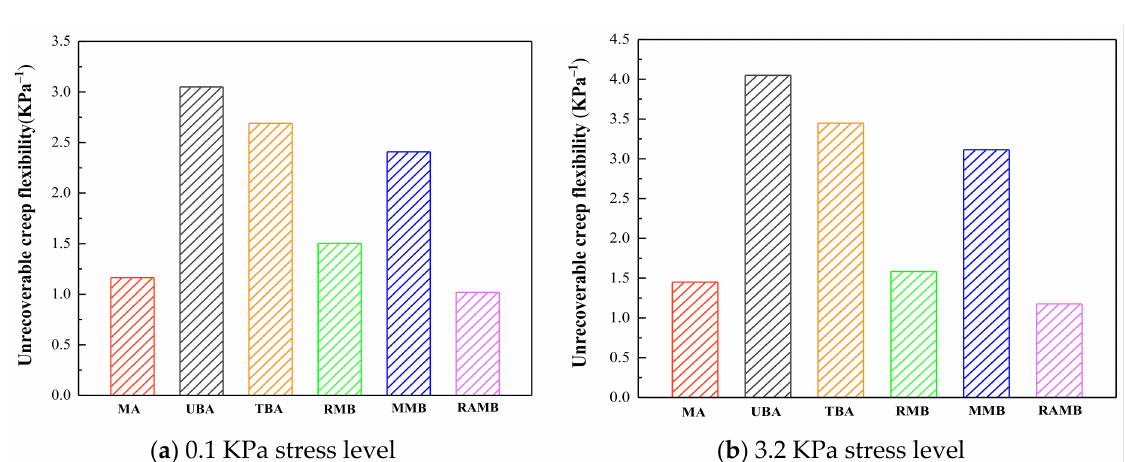
Figure 8. J nr value of different